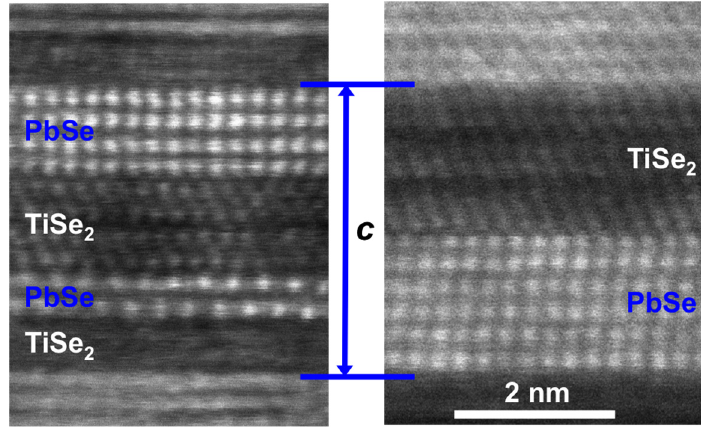
Figure 14. HAADF-STEM data for the 3: 3 and its structural isomer 1: 1 :2: 2 . The expected repeating units are observed, and turbostratic disorder is clearly visible in both